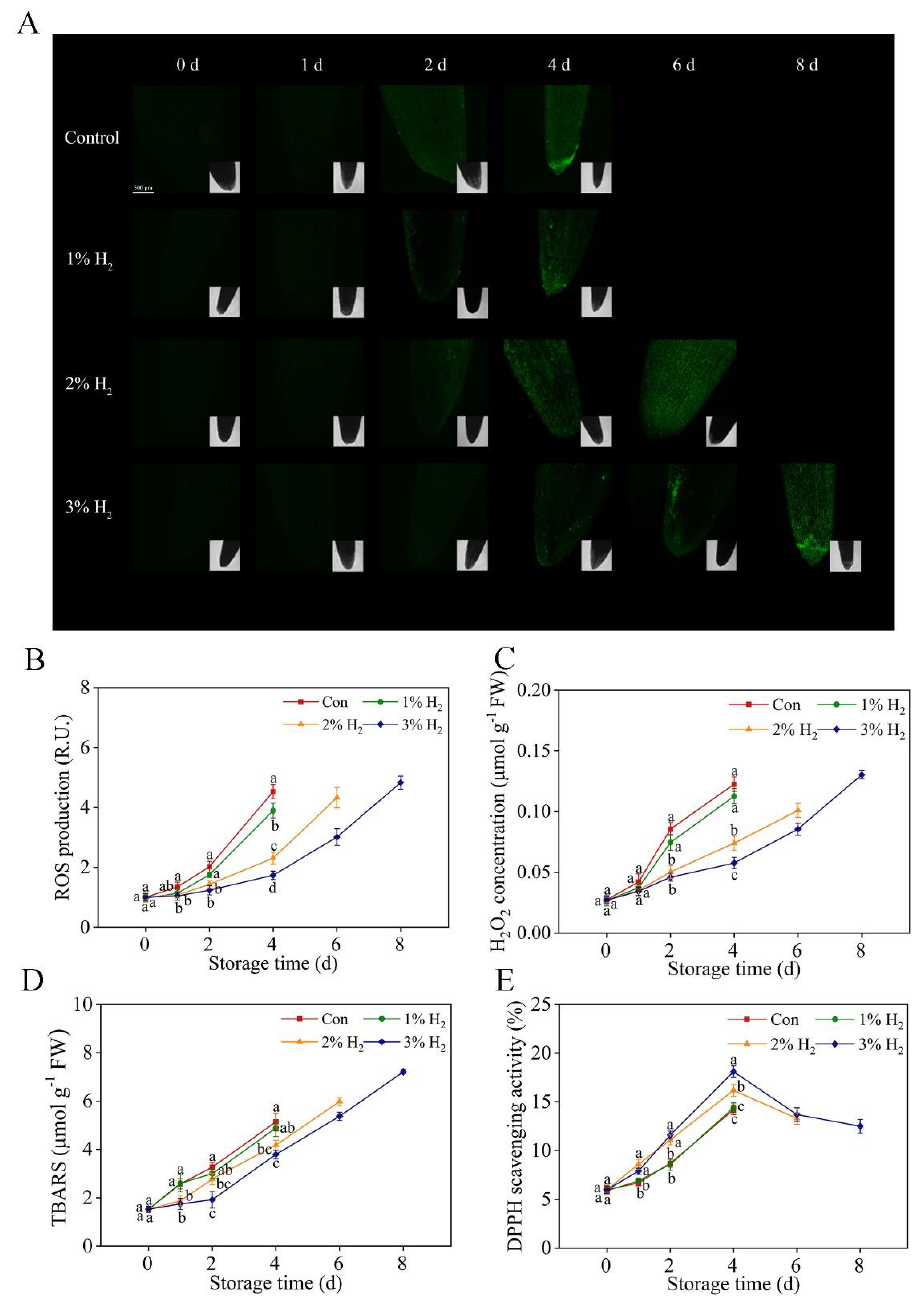
Figure 4. Redox balance was reestablished by molecular hydrogen. Chinese chive was stored at 4 ± 1 °C. The LSCM images of chive leaf apex loading with H 2 DCFDA (a ROS-specific fluorescent probe; ( A )) were provided and the relative fluorescence was presented as values relative to Con at 0 day ( B ). R.U., relative units. Meanwhile, time-dependent changes in hydrogen peroxide (H 2 O 2 ) levels ( C ), TBARS contents ( D ), and DPPH scavenging activity ( E ) of chives were determined. Means ± SE ( n = 5 for LSCM imaging, n = 3 for H 2 O 2 content, TBARS content, and DPPH scavenging activity, respectively) followed by different letters for each storage time indicate a statistical difference at p < 0.05. Scale bar = 500 μm.